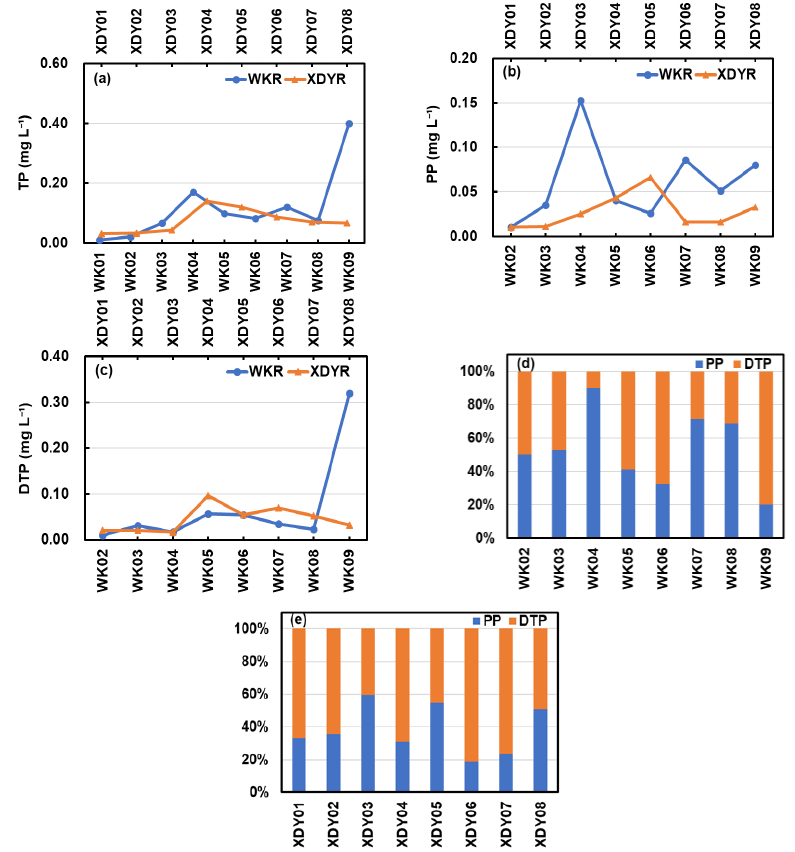
Figure 5. Spatial distribution of: ( a ) total phosphorous (TP), ( b ) particulate phosphorus (PP), and ( c ) dissolved total phosphorus (DTP) ) of the sampling sites in the WangKuai reservoir route (WKR) and XiDaYang reservoir route (XDYR), and the percentages of PP and DTP in TP in ( d ) the WKR and ( e ) the